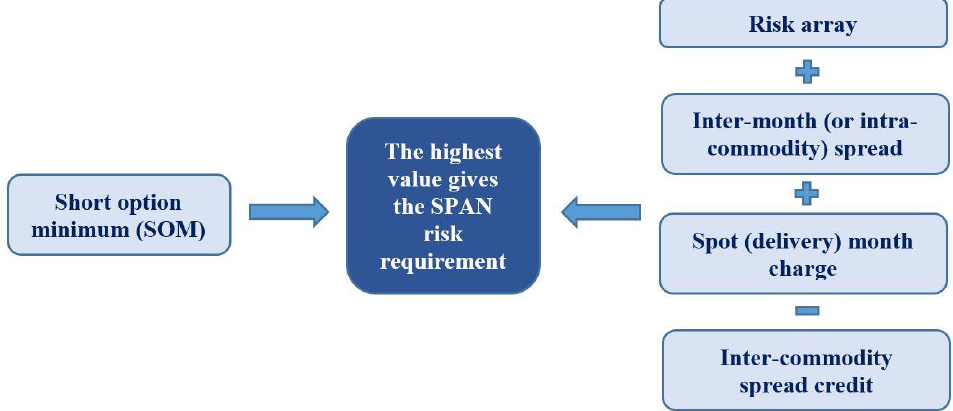
Figure 3. SPAN methodology.